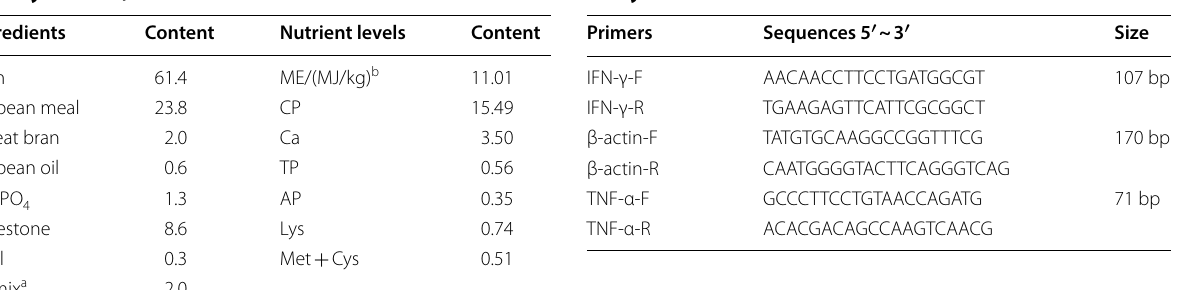
Table 2 Primers used for quantitative real-time